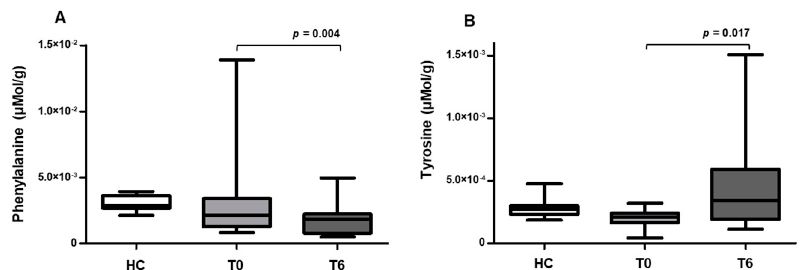
Figure 1. Phenylalanine and tyrosine fecal concentrations in HC and HIV + patients before T0 and after T6 oral probiotics supplementations. ( A ) Phenylalanine fecal concentration in HC and HIV + subjects measured before T0 and after T6 supplementation with oral probiotics. ( B ) Tyrosine fecal concentration in HC and HIV + subjects before T0 and after T6 supplementation with oral probiotics. The line indicates median population value. Data were analyzed using the Mann–Whitney test